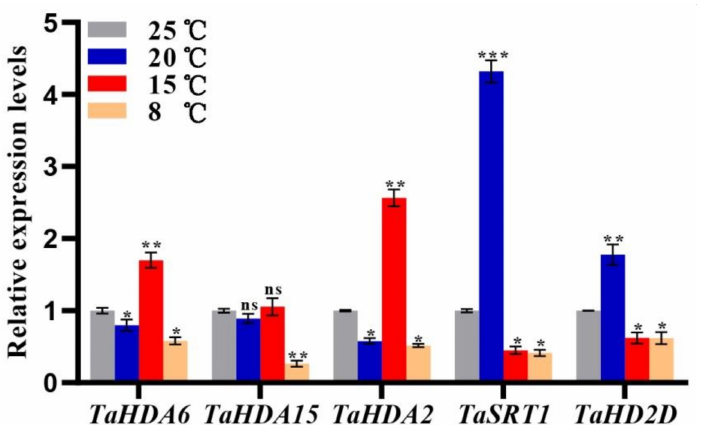
Figure 7. RT-qPCR results of the expression levels of selected TaHDAC genes under diverse tem- perature conditions. The mRNA expression level of each gene in wheat seedlings is presented as the mean ± standard deviation (SD) from 3 biological samples, with each biological sample having 4 technical duplicates. Statistical analyses were performed using the Student’s t -test. Asterisks indicate a significant difference when compared with the control. *, p < 0.05; **, p < 0.01; ***, p < 0.001; ns, no significant